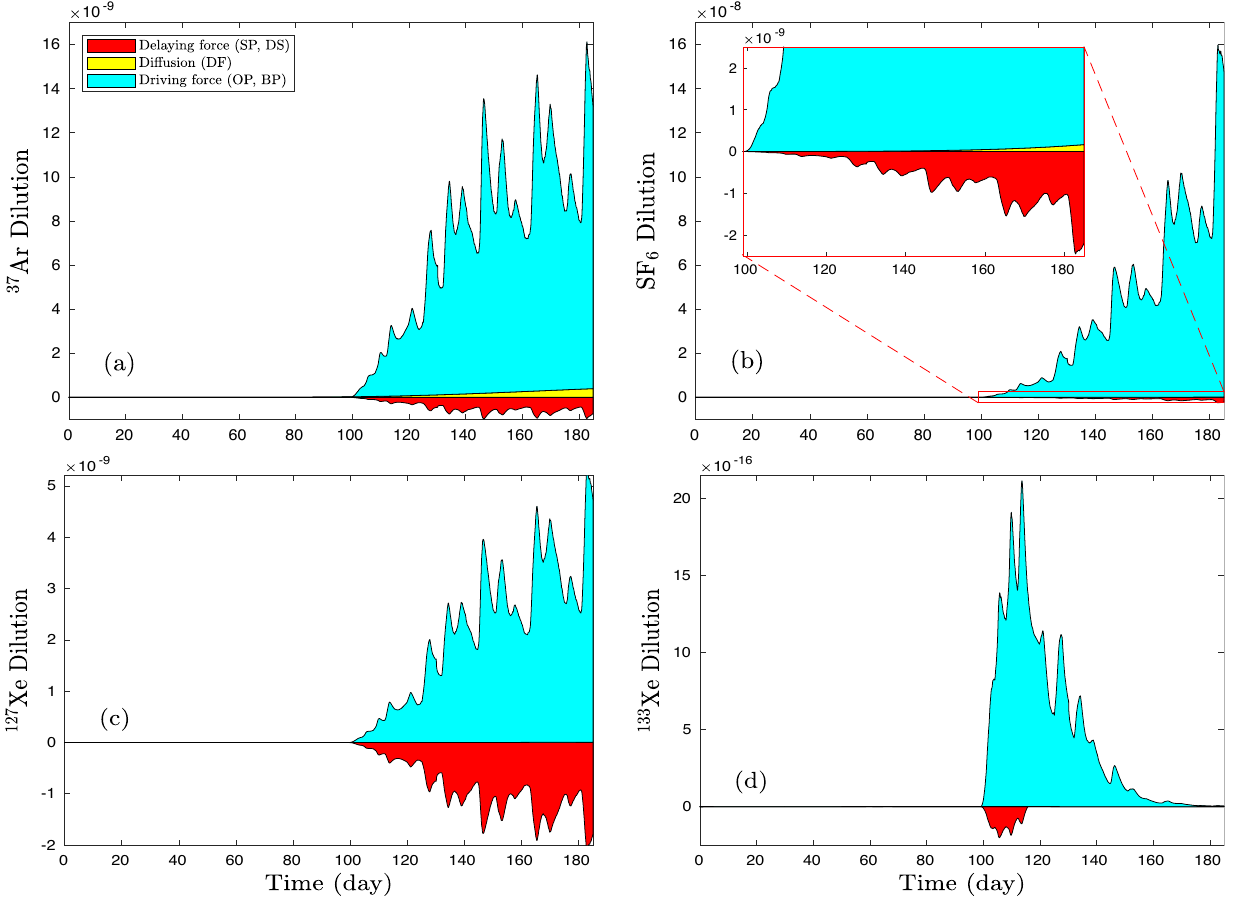
Figure 8. From deterministic models, the contribution of driving and retarding processes to concentration 37 127 133 profiles is plotted for ( a ) Ar, ( b ) SF 6 , ( c ) Xe, and ( d ) Xe at the depth of 0.5 m. The yellow region is the base-model (#0) profile, the red region shows the concentration difference between model #7 and model #6 indicating the effect of retarding processes (sorption and dissolution), and the cyan region shows the concentration difference between model #6 and model #0 indicating the effect of driving force (overpressure and barometric